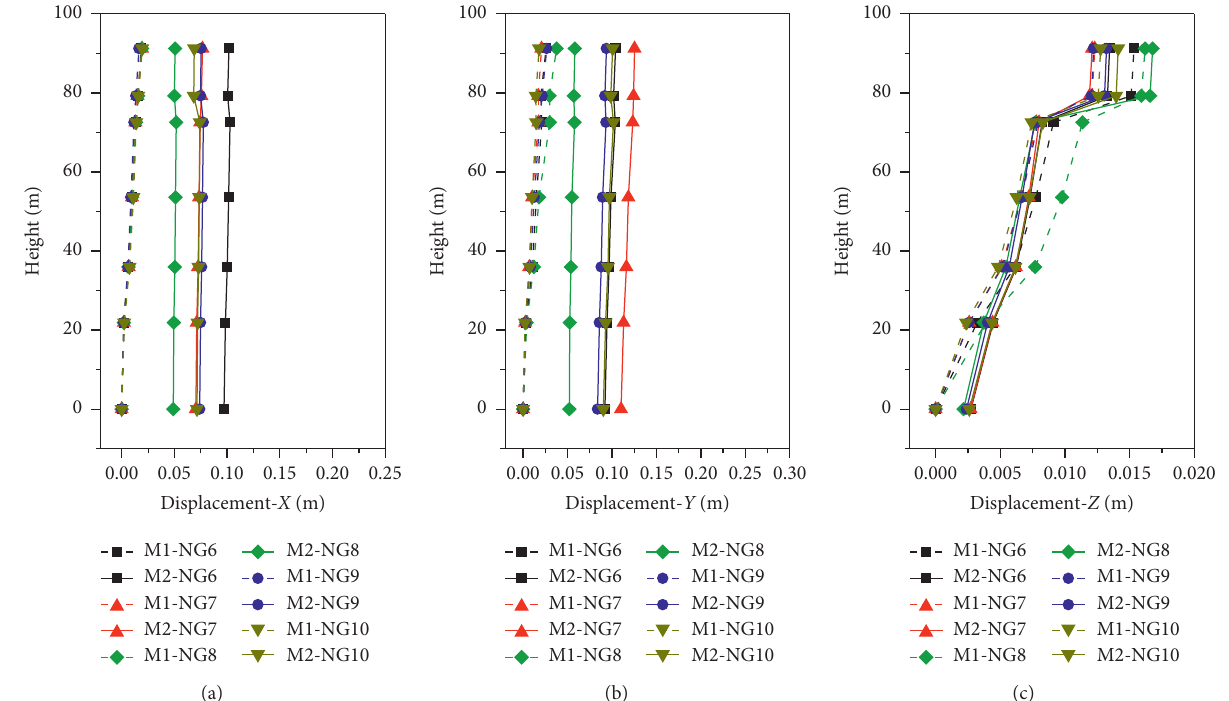
Figure 17: Comparison of peak relative displacement along the height of structure under NG6-NG10: (a) X -direction, (b) Y -direction, and (c) Z -direction.